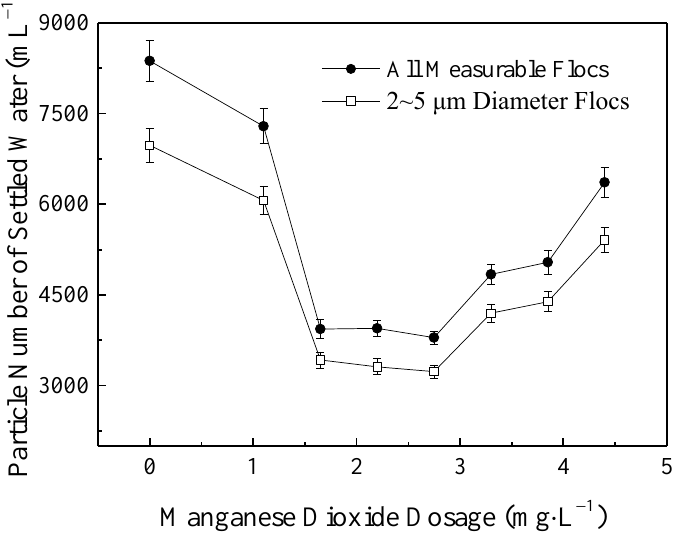
Figure 2. Number of all measurable flocs and microflocs in settled water treated with MnO 2 .